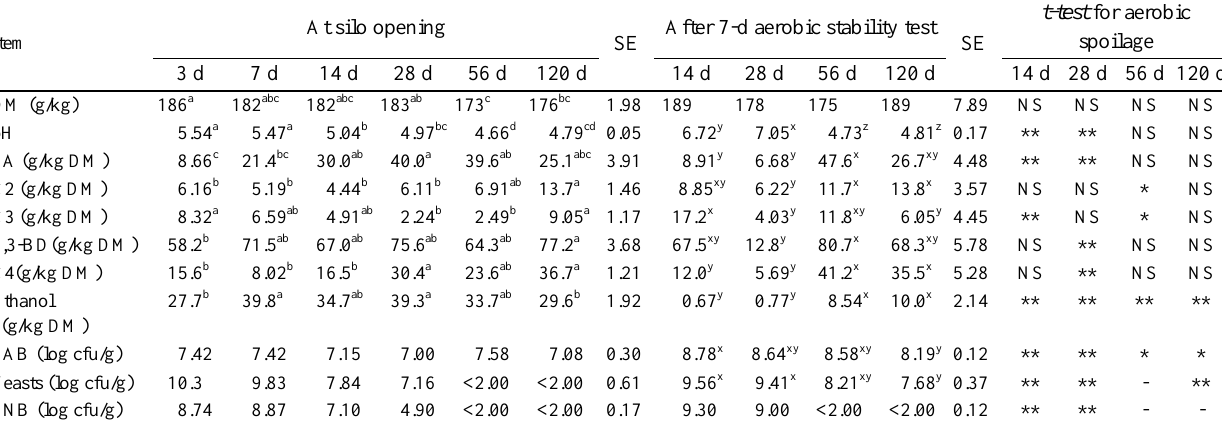
Table 2. Fermentation product contents and microbial counts of direct-cut Italian ryegrass silage determined at silo opening and after conducting a 7-d aerobic stability